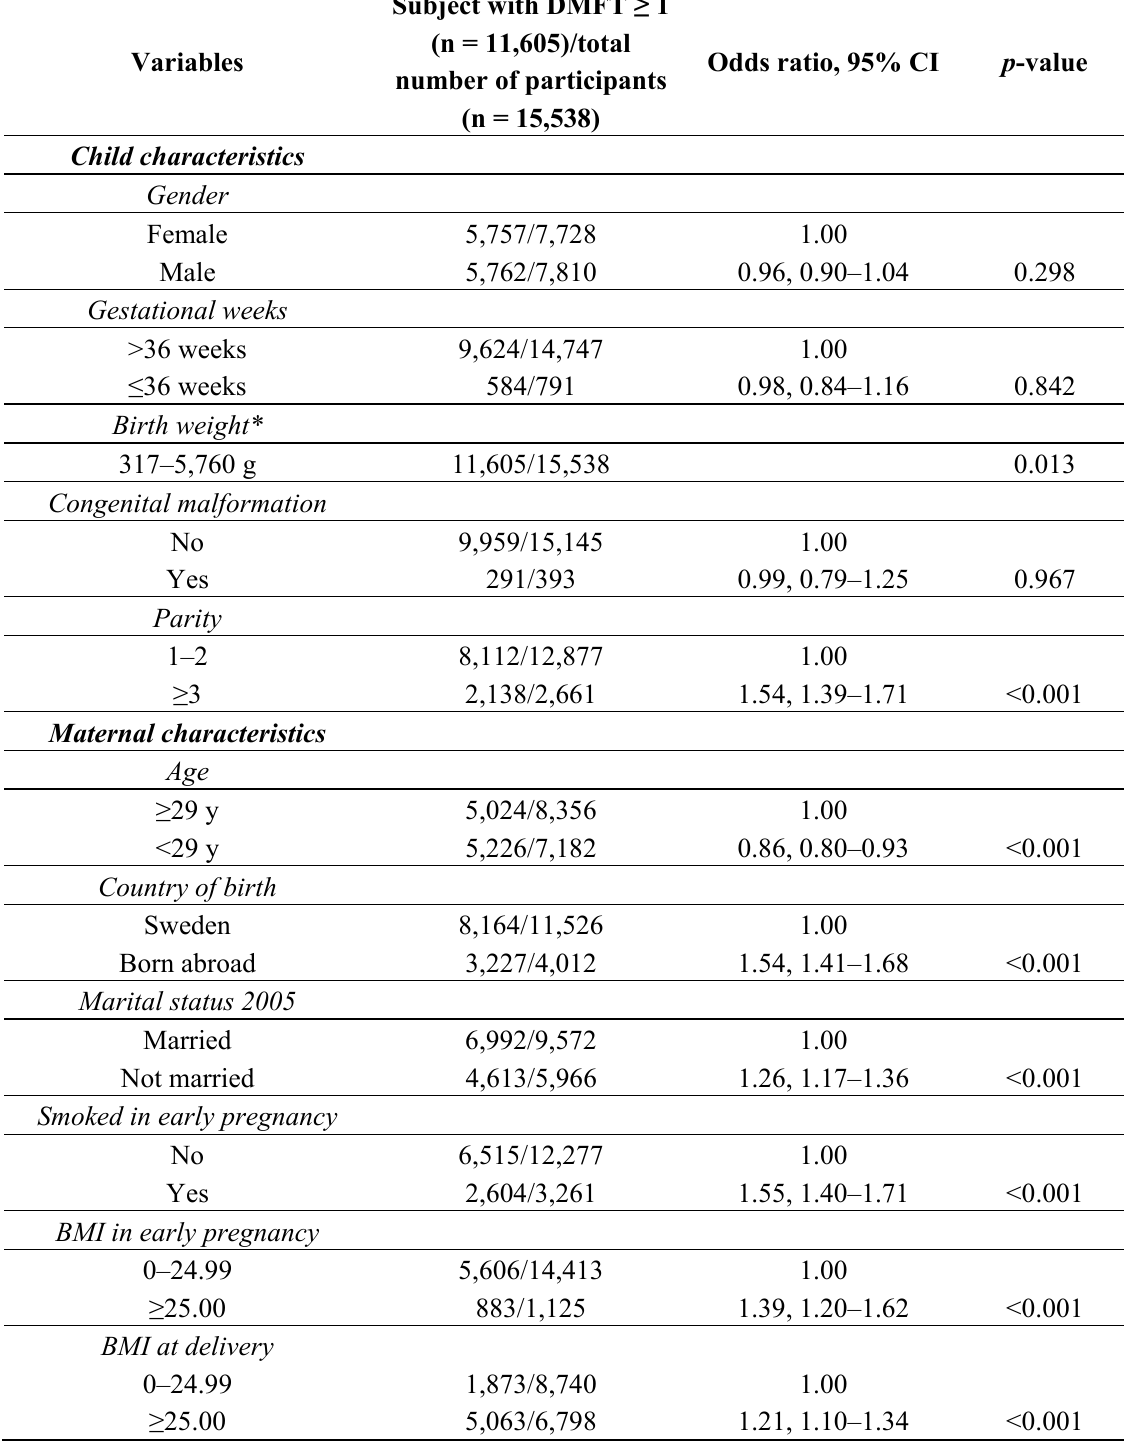
Table 2. Univariate logistic regression analysis with pre-, peri-natal and sociodemographic factors, such as exposure and caries experience (DMFT ≥ 1) at 19 years of age, as the